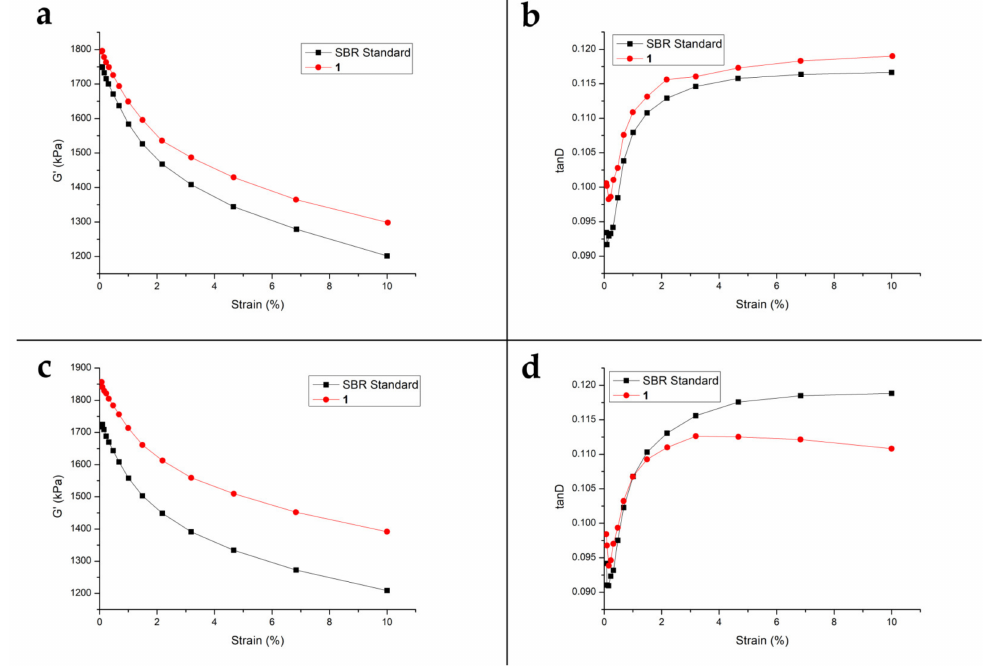
Figure 7. Dynamic mechanical properties of final compound treated with bistetrazole 1 : ( a ) G’ mea- sured after curing at 150 ◦ C; ( b ) tan delta after curing at 150 ◦ C; ( c ) G’ measured after second curing at 190 ◦ C; ( d ) tan delta after second curing at 190 ◦